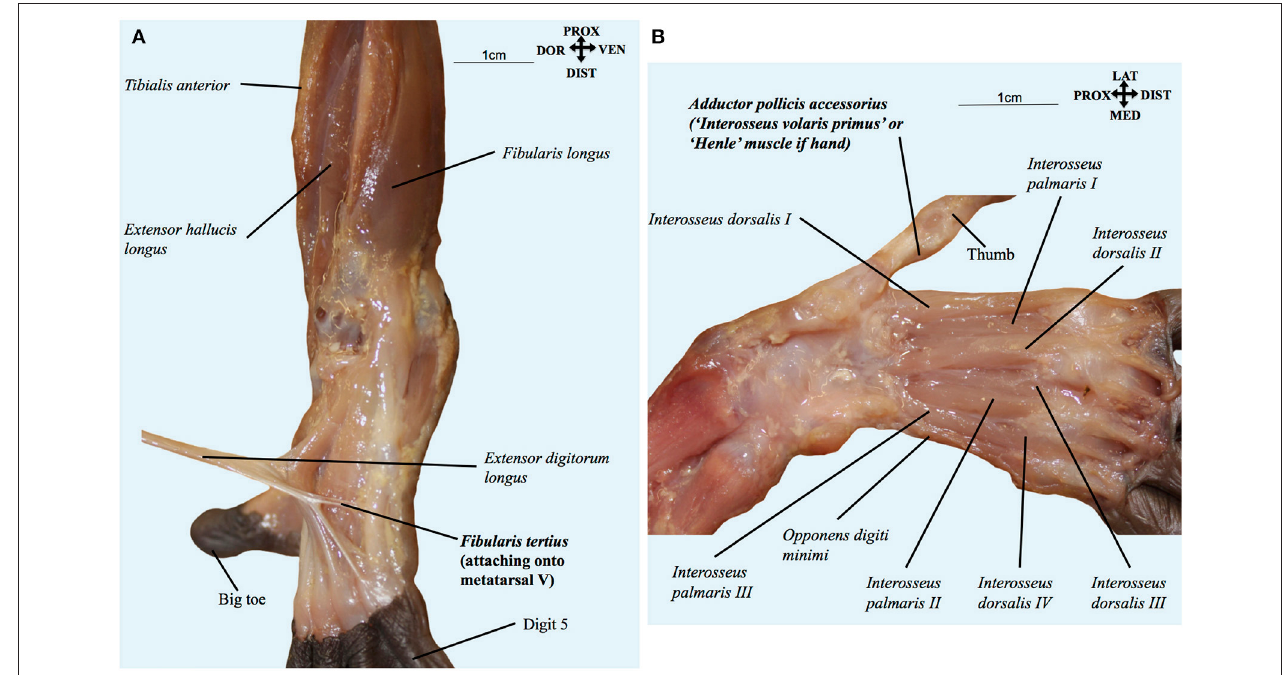
FIGURE 4 | (A) Pan paniscus (ZIMS 164052, Ano, fetus female): dorsolateral view of the superficial muscles of the left foot. Extensor digitorum longus is detached showing the fibularis tertius tendon going to the fifth metatarsal. Modified from Diogo et al.’s photographic atlas of bonobos Diogo et al. (2017a); © Diogo has copyright of this atlas. (B) Pan paniscus (ZIMS 164052, Ano, fetus female): ventral view of the deep muscles of the hand after removal of contrahentes; note the presence of the adductor pollicis accessorius (“interosseus volaris primus or Henle’s muscle”). Modified from Diogo et al.’s photographic atlas of bonobos Diogo et al. (2017a); © Diogo has copyright of this